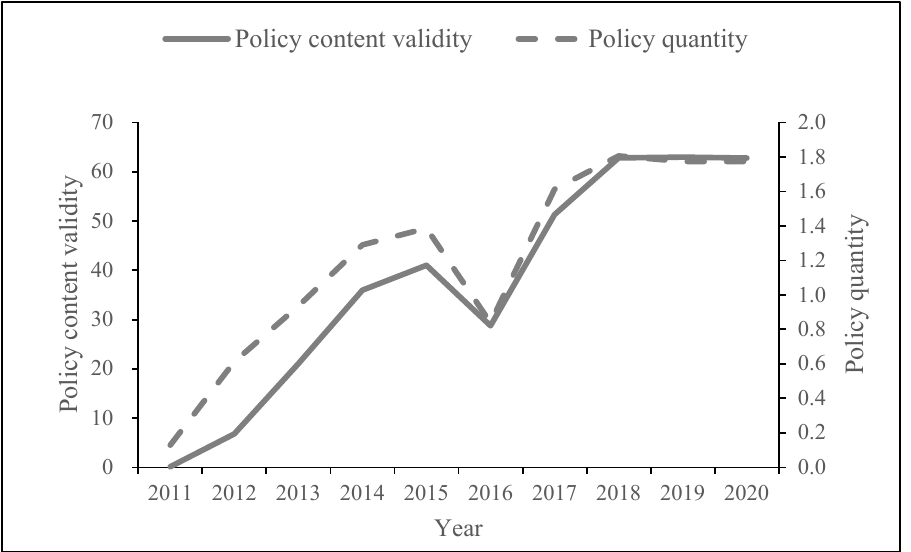
Figure 1. Content validity and quantity of National CET Policy (2011–2020). (Note: the data supporting the figure were calculated by the authors.).